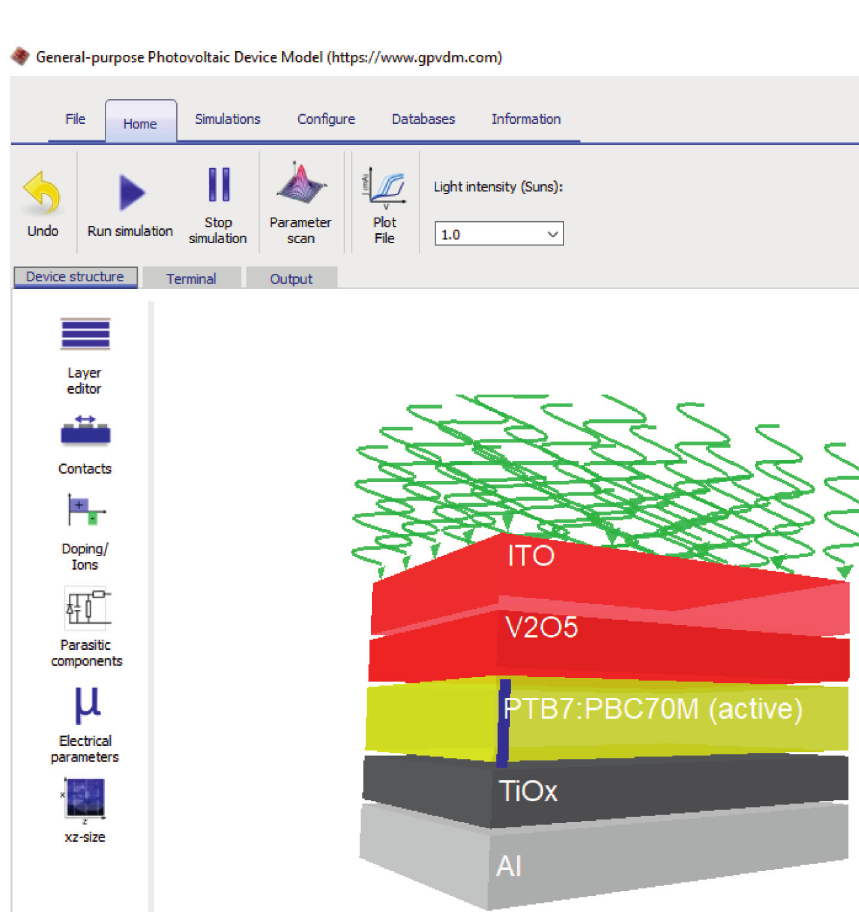
Figure 3: Electrical simulation window for the architecture of the studied solar cell.